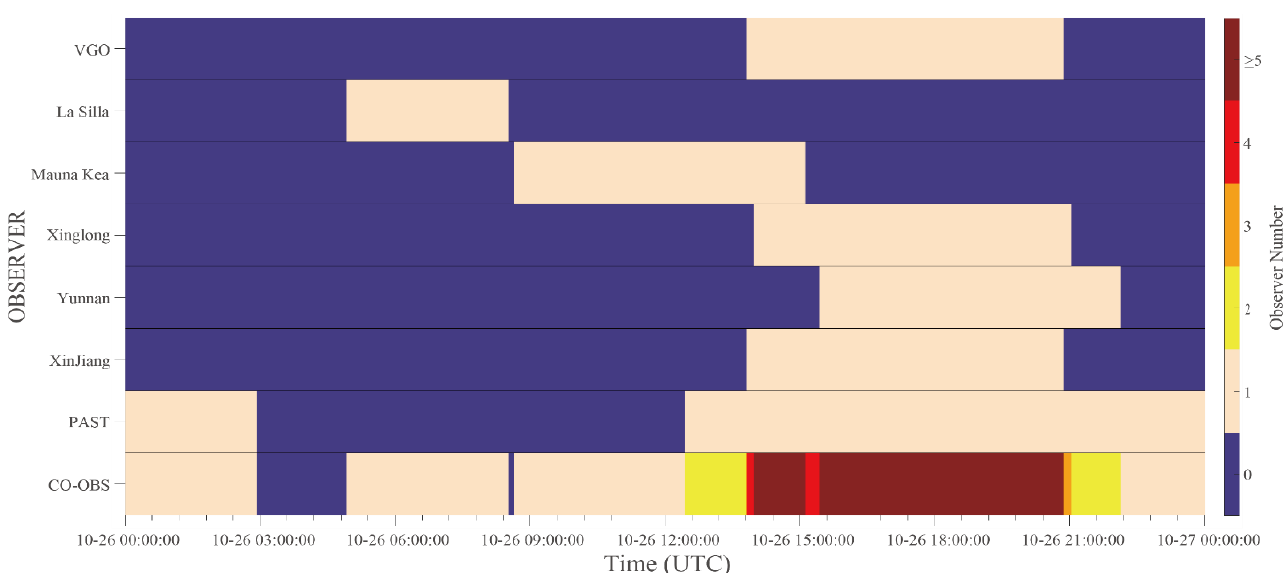
Figure 12. Observation windows for seven observatories and joint observation (noted as CO-OBS) for observing Mars on 26 October 2022. Colormap for single observatory indicates OBW . CO-OBS indicates the number of observers available simultaneously.